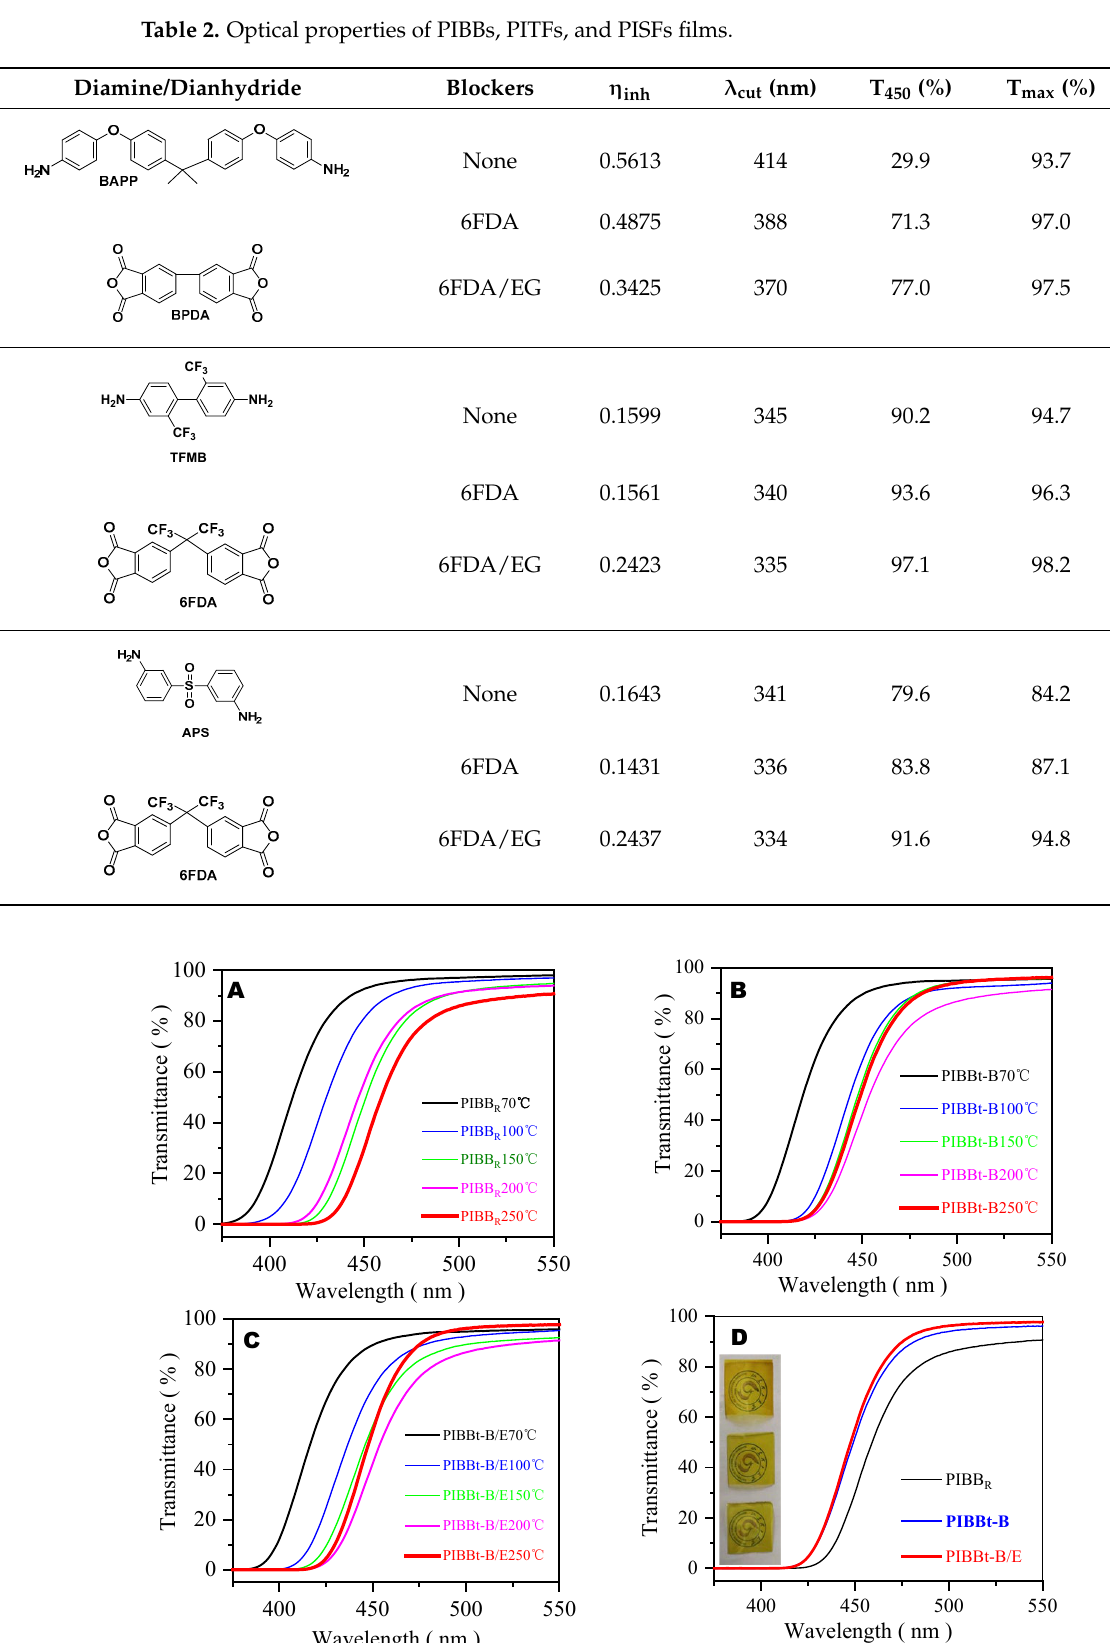
Table 2. Optical properties of PIBBs, PITFs, and PISFs films.